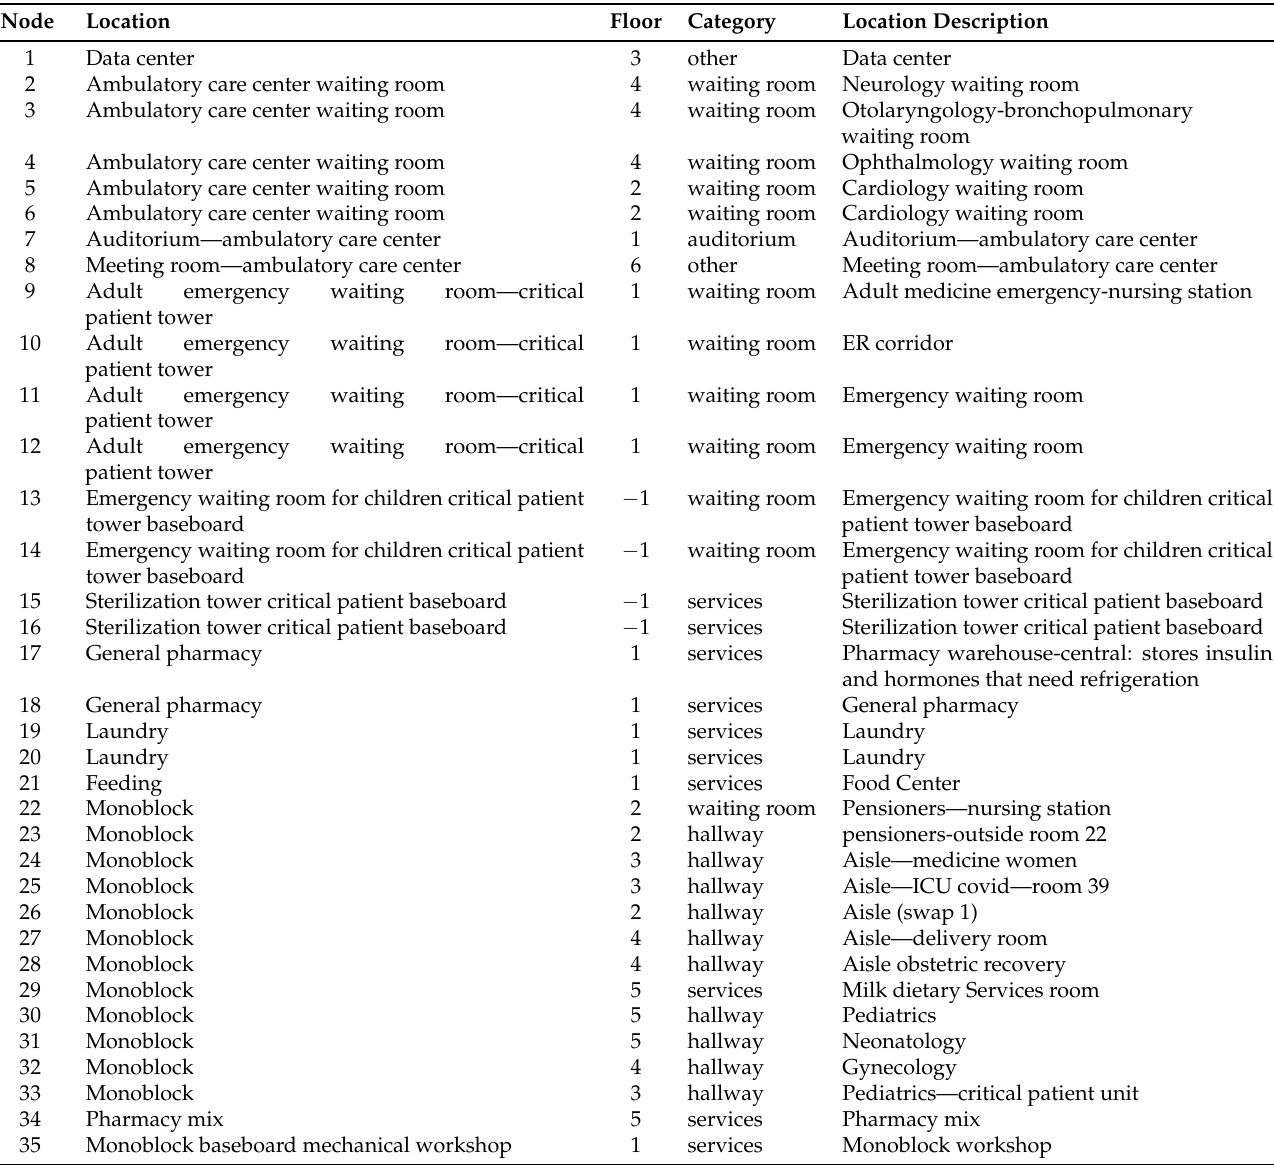
Table 1. The node sensors’